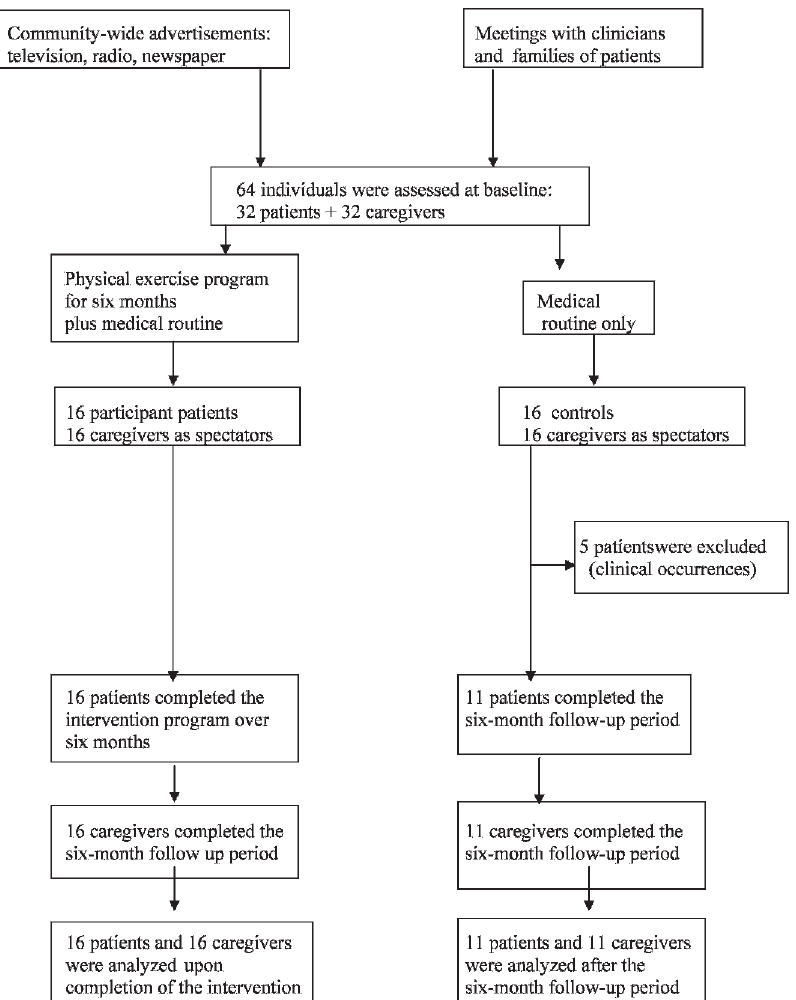
Figure 1 - Flow diagram of disclosure, patient recruitment, intervention,